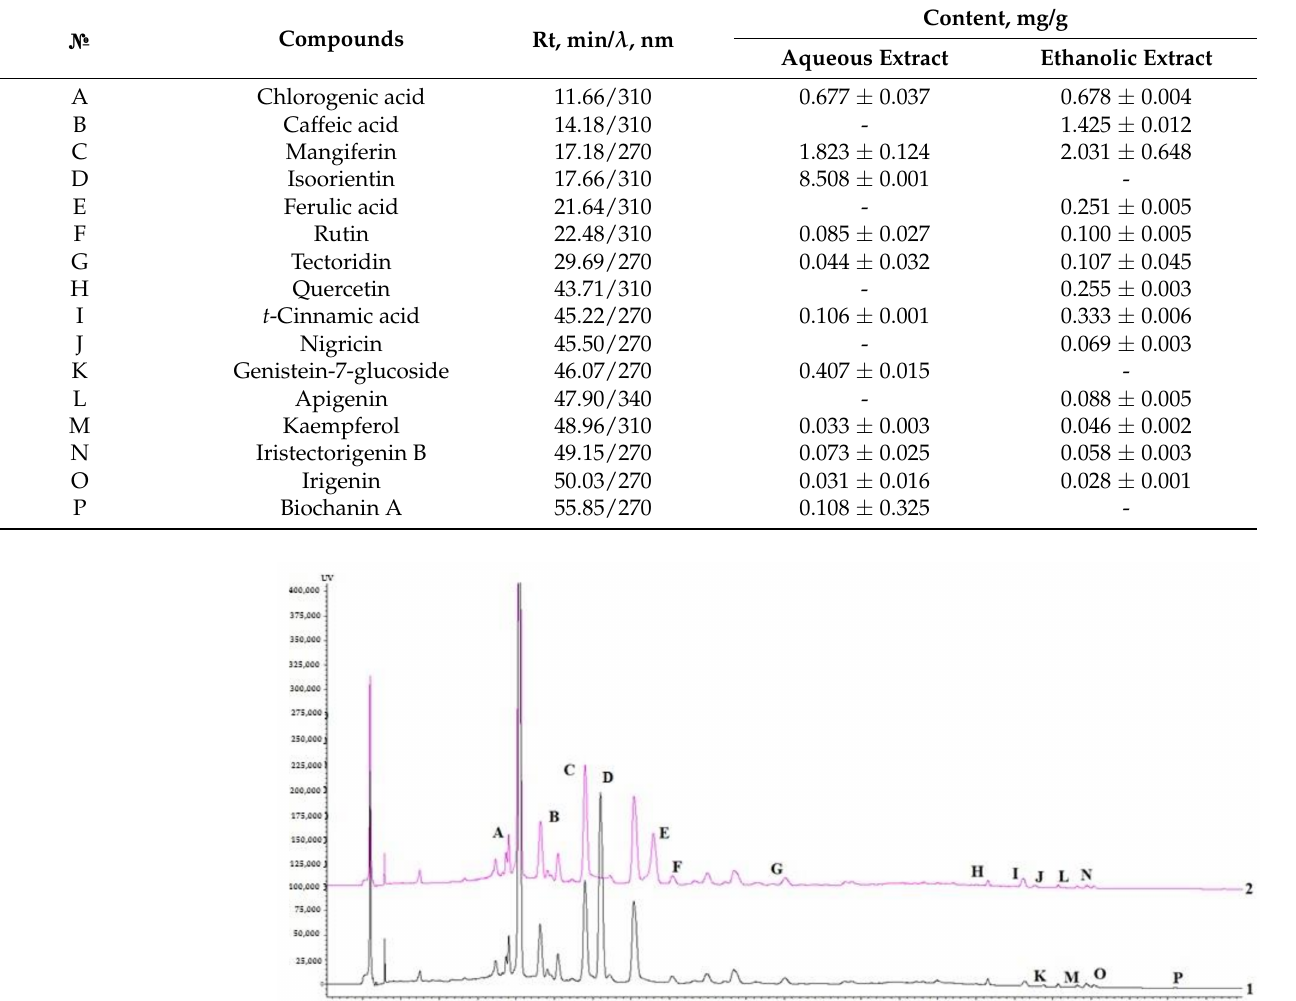
Figure 1. HPLC–DAD chromatograms of C. sativus leaves aqueous (black line 1) and ethanolic (70%, v / v ) (pink line 2) dry extracts: Chlorogenic acid (A); Caffeic acid (B); Mangiferin (C); Isoorientin (D); Ferulic acid (E); Rutin (F), Tectoridin (G); Quercetin (H); Cinnamic acid (I); Nigricin (J); Genistein-7- glucoside (K); Apigenin (L); Kaempferol (M); Iristectorigenin B (N); Irigenin (O); Biochanin A